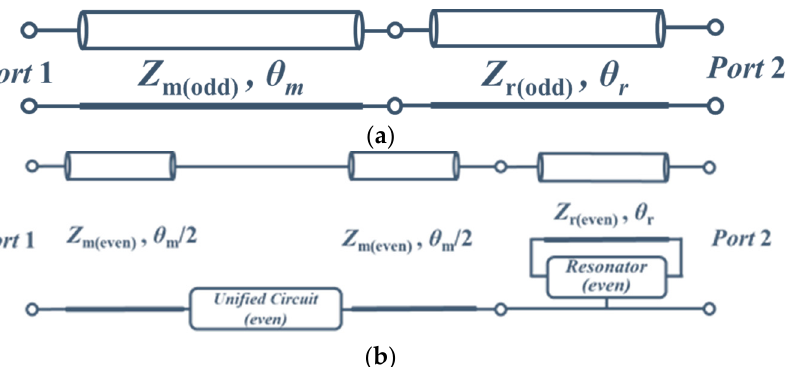
Figure 1. Schematic of the proposed structure.